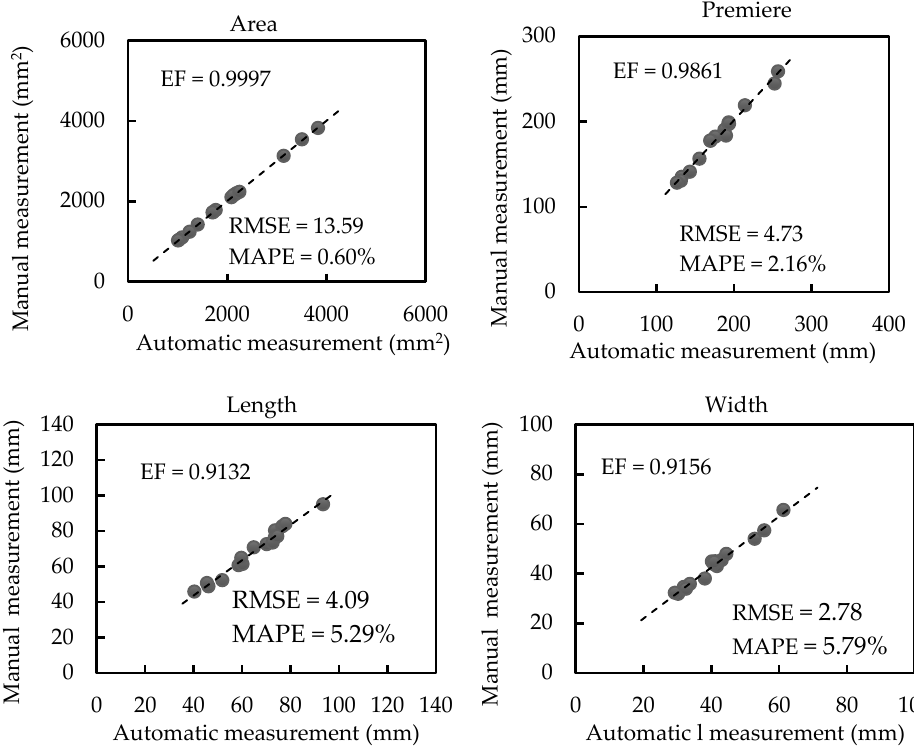
Figure 7. Regression analyses between automatic and manual measurements of scale-related traits of plants with no occlusion (plants in group 1).